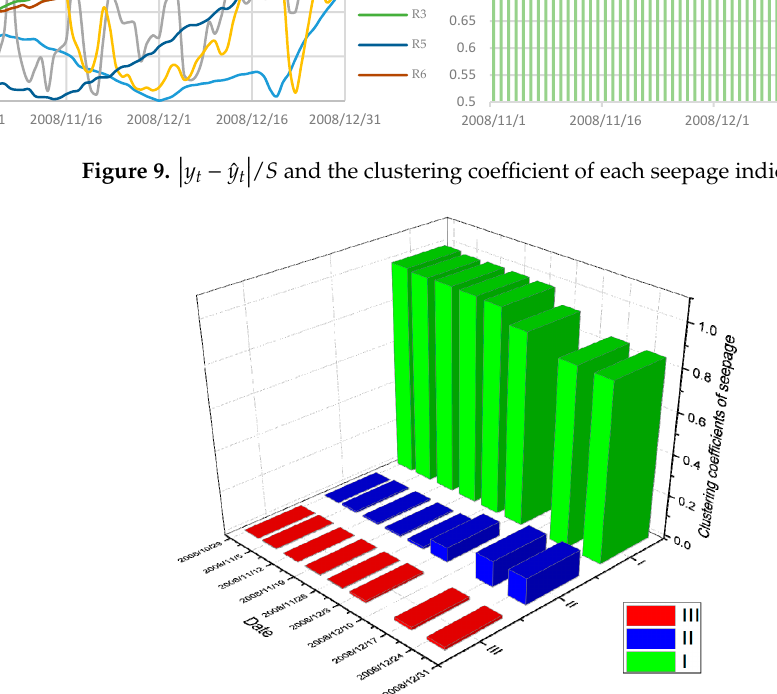
Figure 10. Comprehensive clustering coefficient histogram of seepage.